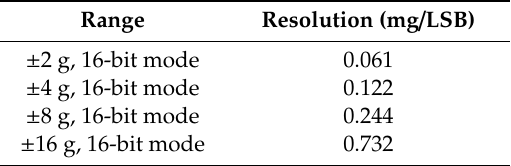
Figure 3. Schematic of IoT vibration sensor node using Raspberry Pi, microelectromechanical systems (MEMS) accelerometer, and 4G communication. Table 1. Resolutions of LSM9DS1 MEMS accelerometer corresponding to various measurement